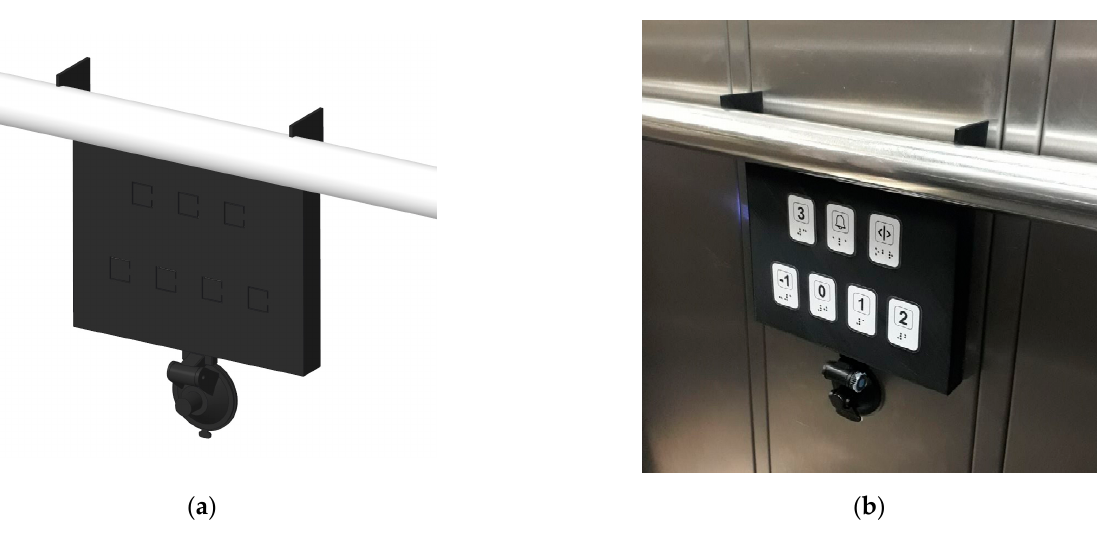
Figure 5. Back view of the IoT device: ( a ) CAD representation; ( b ) real implementation.